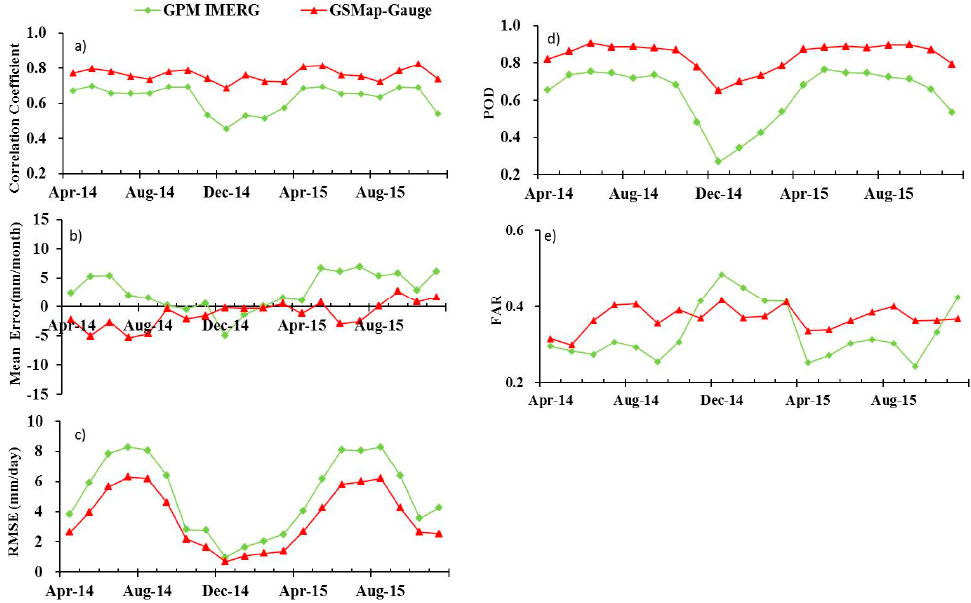
Figure 6. Monthly time series of ( a ) CC; ( b ) ME; ( c ) RMSE; ( d ) POD; and ( e ) PAR.